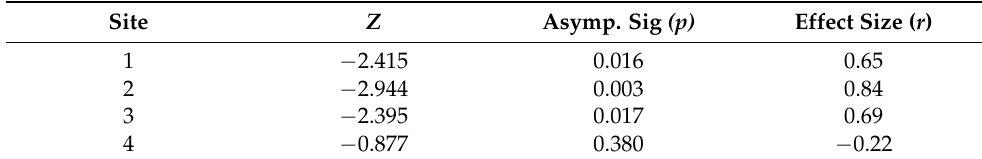
Table 2. Breakdown of changes to well-being in Sierra Leone surf therapy.